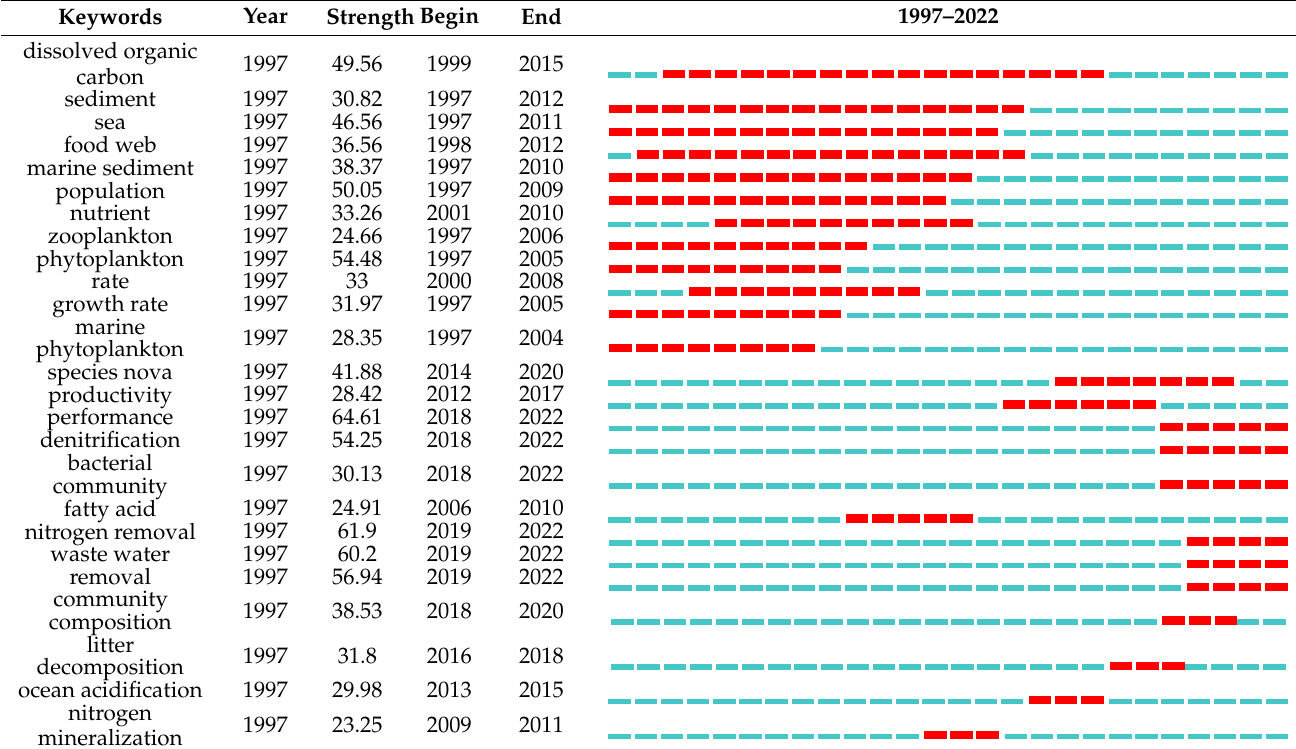
Table 12. Top 25 keywords with the strongest citation bursts during